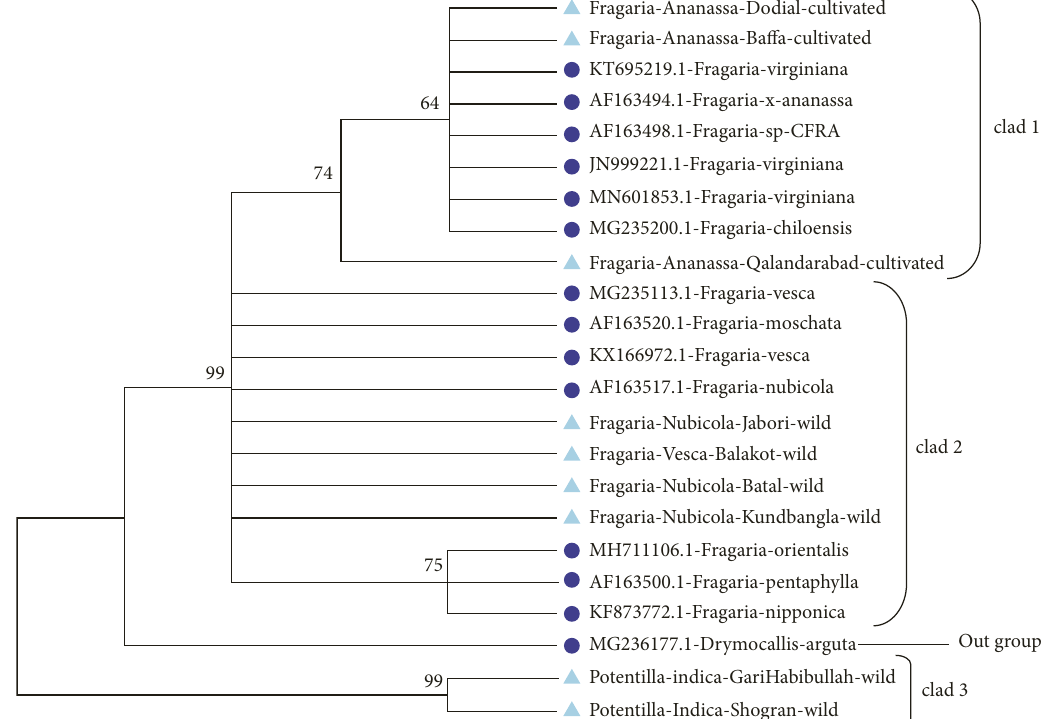
Figure 12: Phylogenetic tree of selected Fragaria species ( ITS2 ) with related reference Fragaria species through the neighbor-joining method.